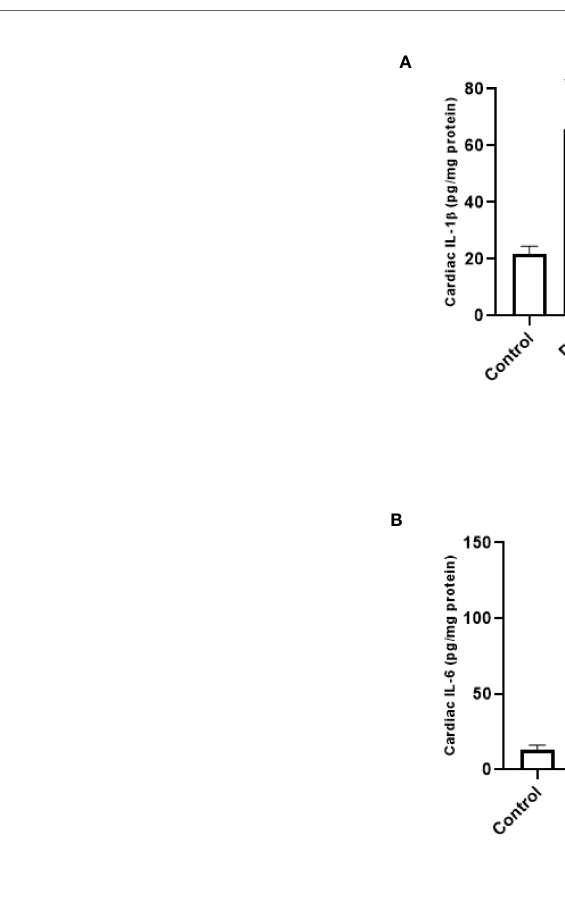
FIGURE 5 | Effect of dapagli fl ozin (Dapa) and liraglutide (Lira) or their combination on protein levels of (A) tissue IL-1 b and (B) tissue IL-6. Data are represented as mean ± SE, n = 5. ** signi fi cance in comparison with control group at p < 0.01, **** at p < 0.0001, ## signi fi cance in comparison with diabetic group at p < 0.01, #### at p < 0.0001, ~~~~ signi fi cance in comparison with DM+Dapa at p < 0.0001, $$$$ signi fi cance in comparison with DM+Lira group at p <